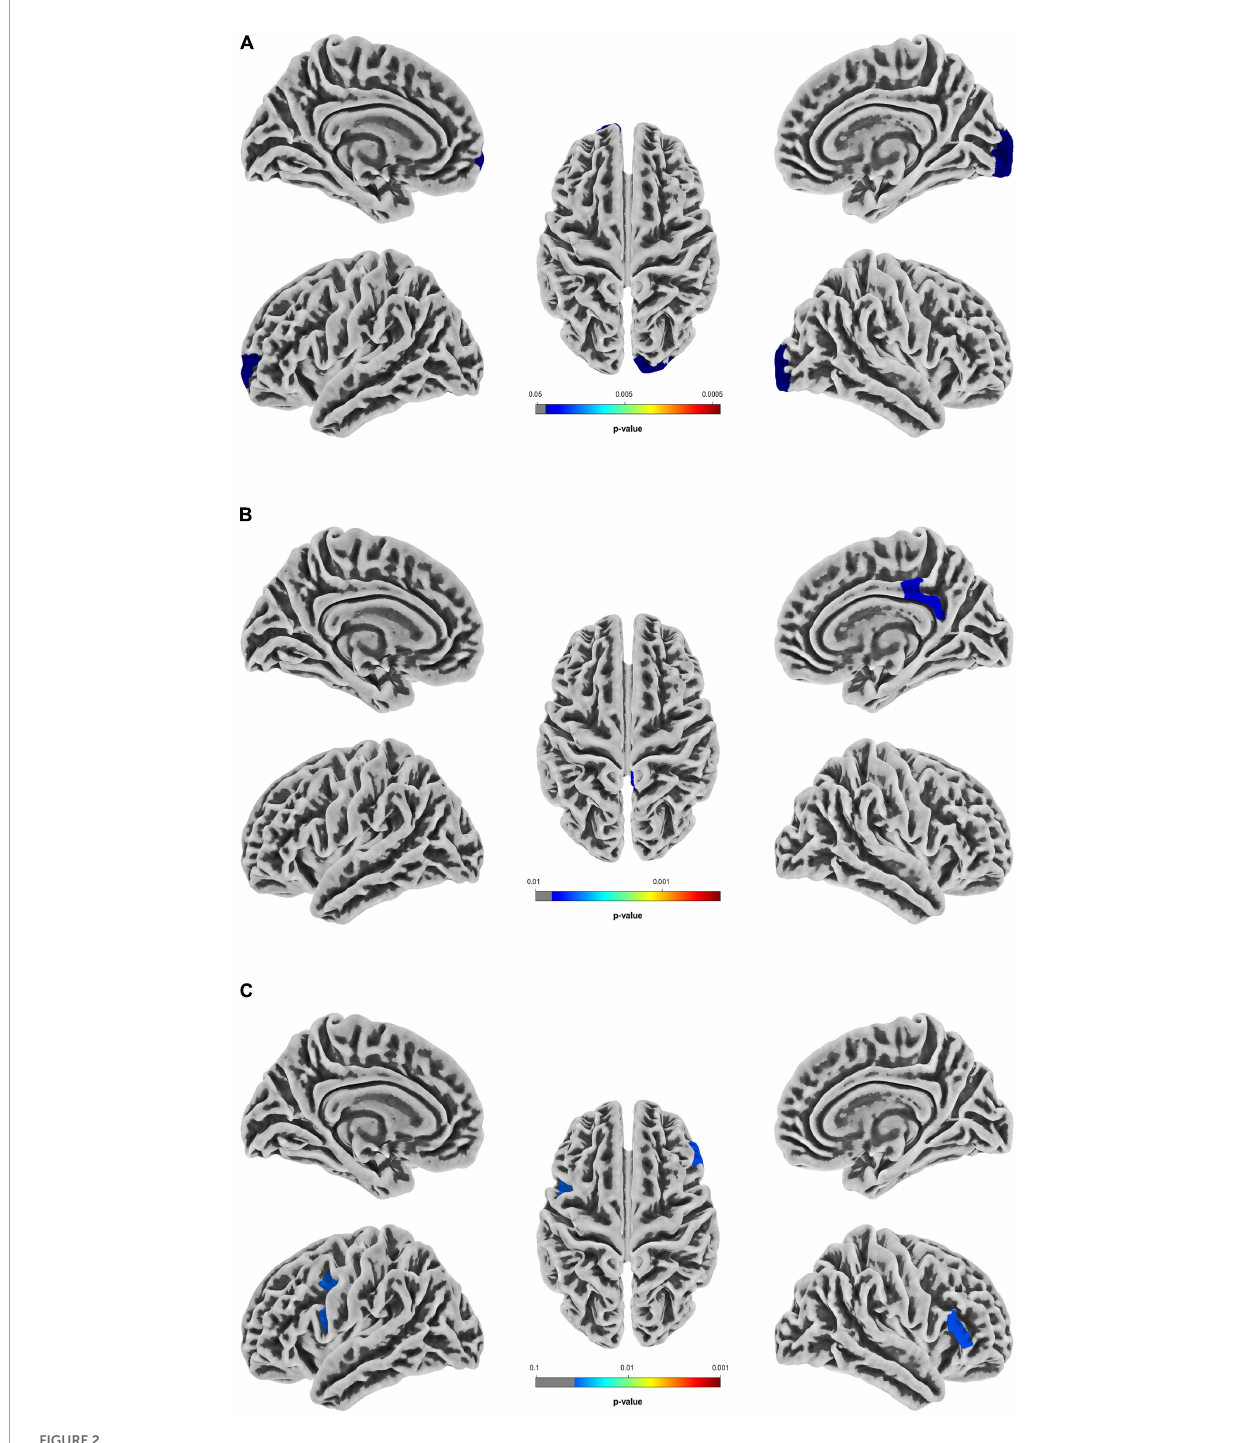
FIGURE2 Differential brain regions in the SBM indices between T2DM patients with normal cognitive function and healthy controls. (A) Differential brain regions with intergroup differences in sulcus depth. (B) Differential brain regions with intergroup differences in fractal dimension. (C) Differential brain regions with intergroup differences in gyrification index. Two sample t-test, Holm-Bonferroni corrected. T2DM, type 2 diabetes mellitus group; SBM, surface-based morphometry.